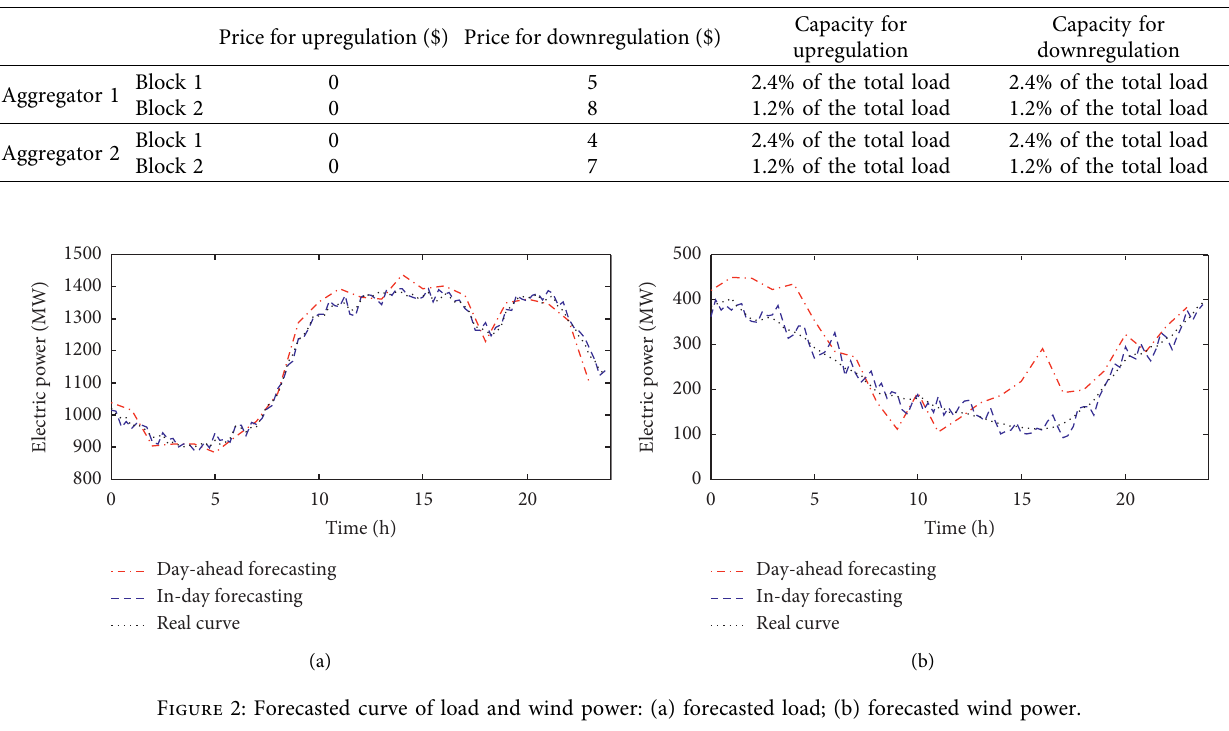
Table 2: Parameters of the shiftable